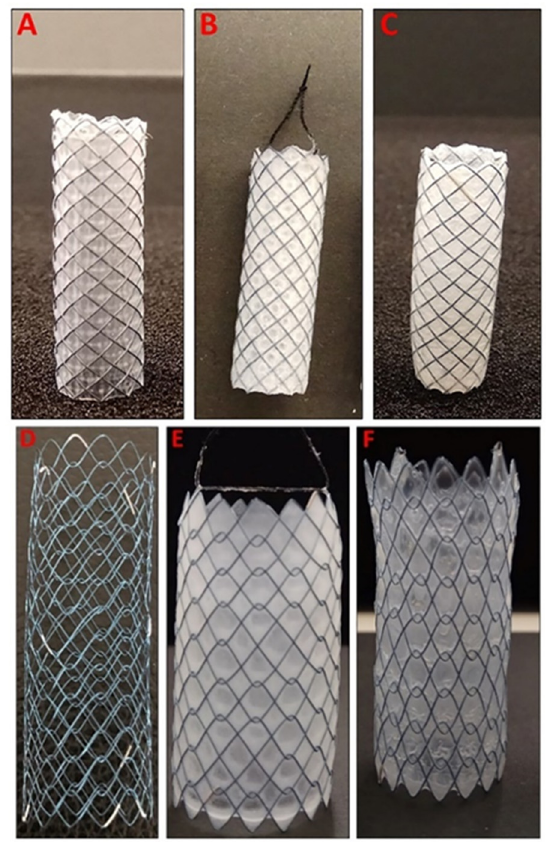
Figure 1. ( A ) Silicone membrane-covered self-expanding nitinol stent (fixed cells with braided structure), ( B ) Si-PU 5FU stent and ( C ) Si-PU 5FU -PEVA stent. ( D ) Uncovered (bare) self-expanding nitinol stent (unfixed cells with weaving structure), ( E ) B-PU 5FU stent and ( F ) B-PU 5FU -PEVA stent.